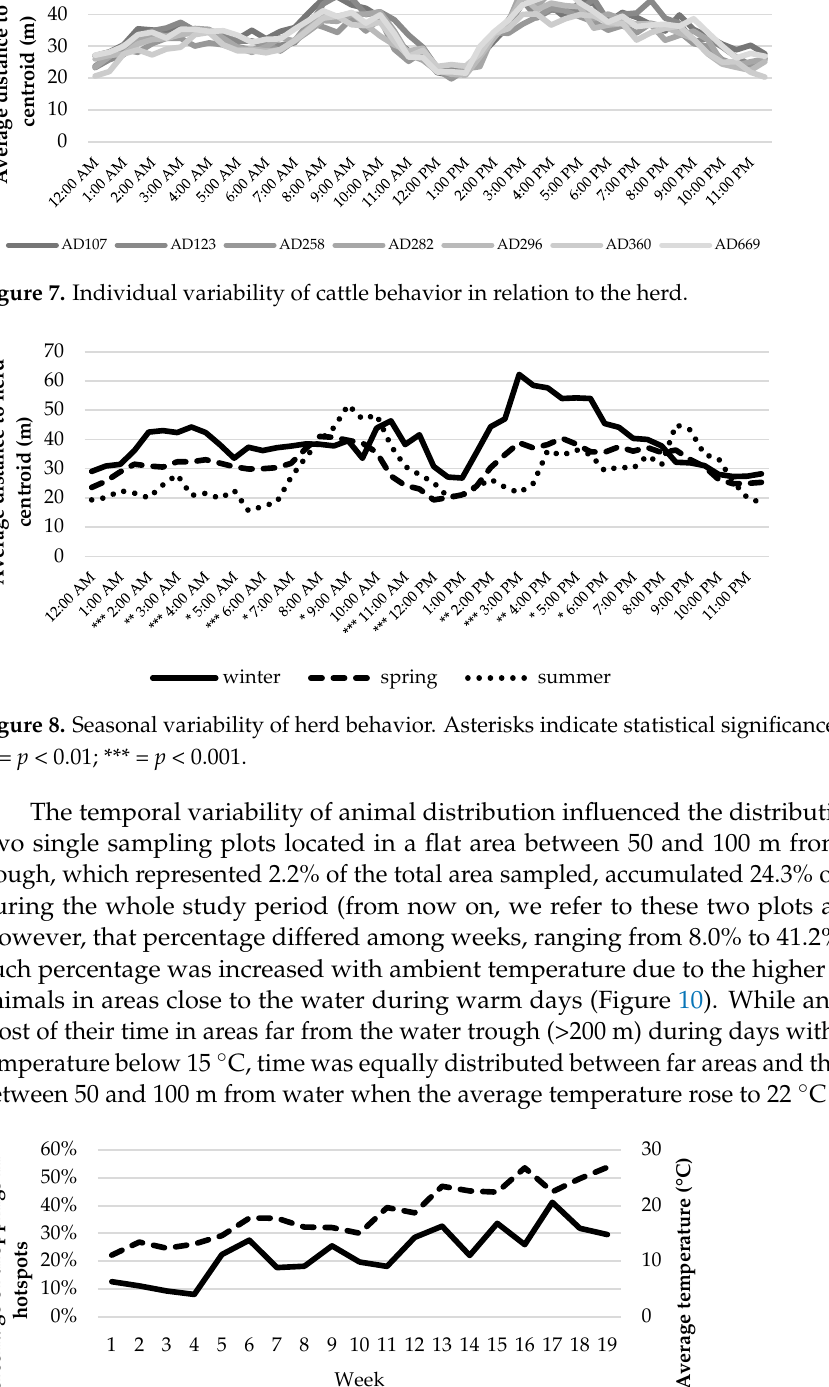
Figure 10. Effect of the interaction ambient temperature-distance to water in dung distribution. An interaction between ambient temperature and canopy cover was also observed for the distribution of dung (Figure 11). Although most droppings were deposited in areas without tree cover, this proportion was even larger on warm days. Cattle may spend more time under trees with higher temperatures, but it did not increase dung deposition in these areas. In contrast, the number of dung pats was reduced in plots with some canopy cover. Figure 11. Effect of ambient temperature-canopy cover interaction in the distribution of dung. 3.3. Relationships between GPS Data and Dung Accumulation in Sampling Plots Figure 12 shows the relationship between the number of feces accumulated in each sampling plot during the experimental period and animal presence in those plots. The presence of animals was represented with three different indicators: number of location fixes, number of trajectory segments, and total time animals spent within the plot. As hotspots accumulated a large proportion of feces and location fixes, they could have a